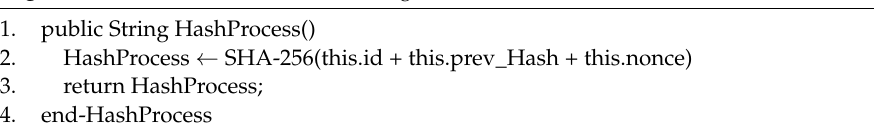
Algorithm 2: Process hash function using SHA-256.